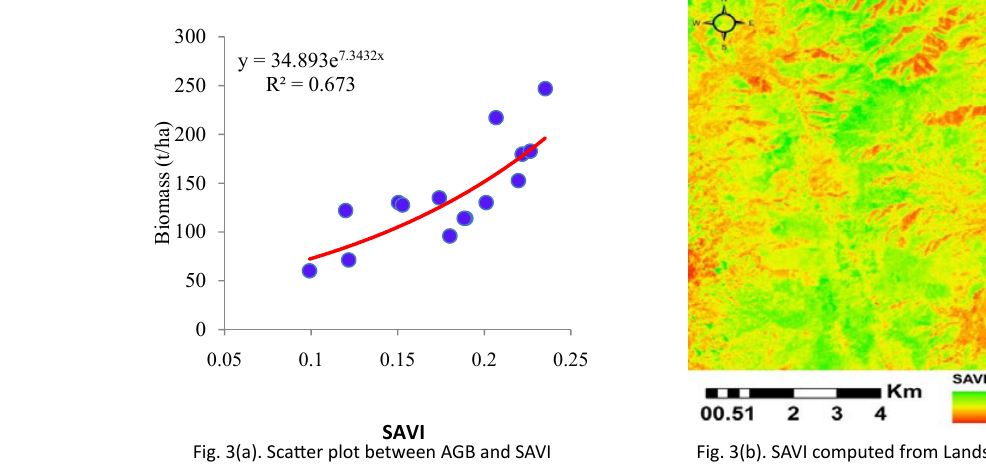
Fig. 3(a): Scatter plot between AGB and SAVI Fig. 3(b): SAVI computed from Landsat ‐ 8 Image